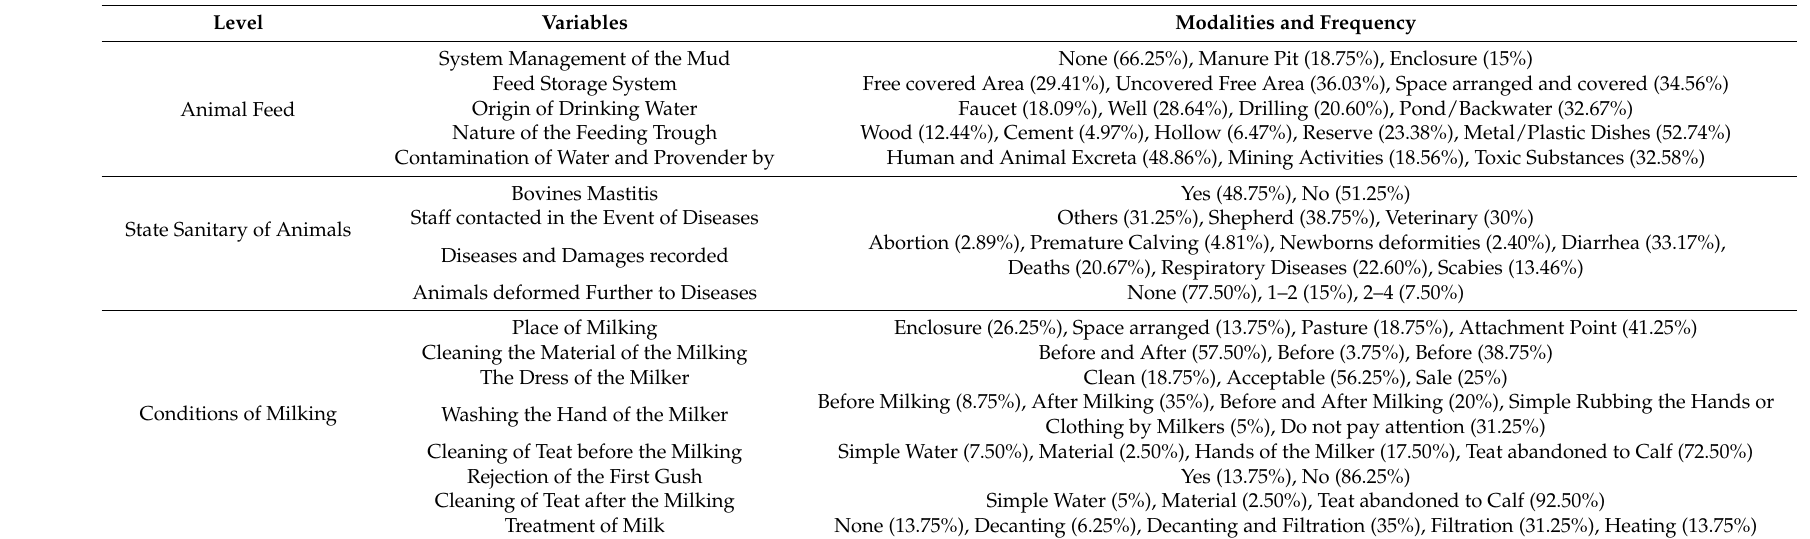
Table 4. Standard sanitary risk at dairy